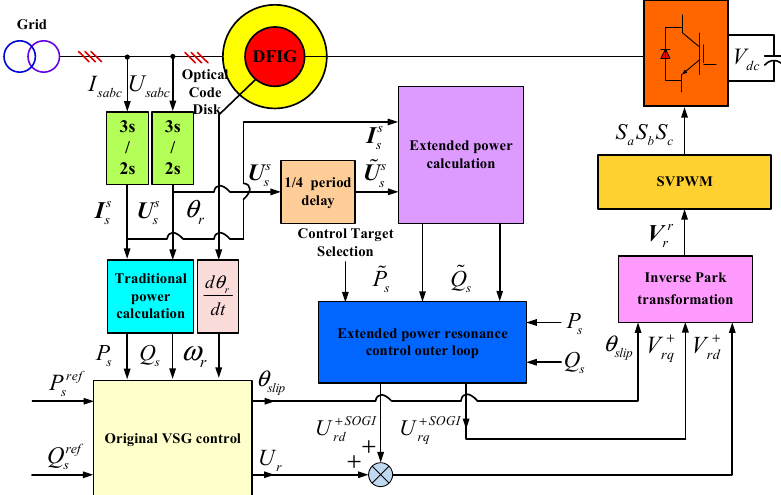
Figure 5. Multi-target operation strategies of the DFIG using VSG control based on the extended power resonance control under unbalanced grid.